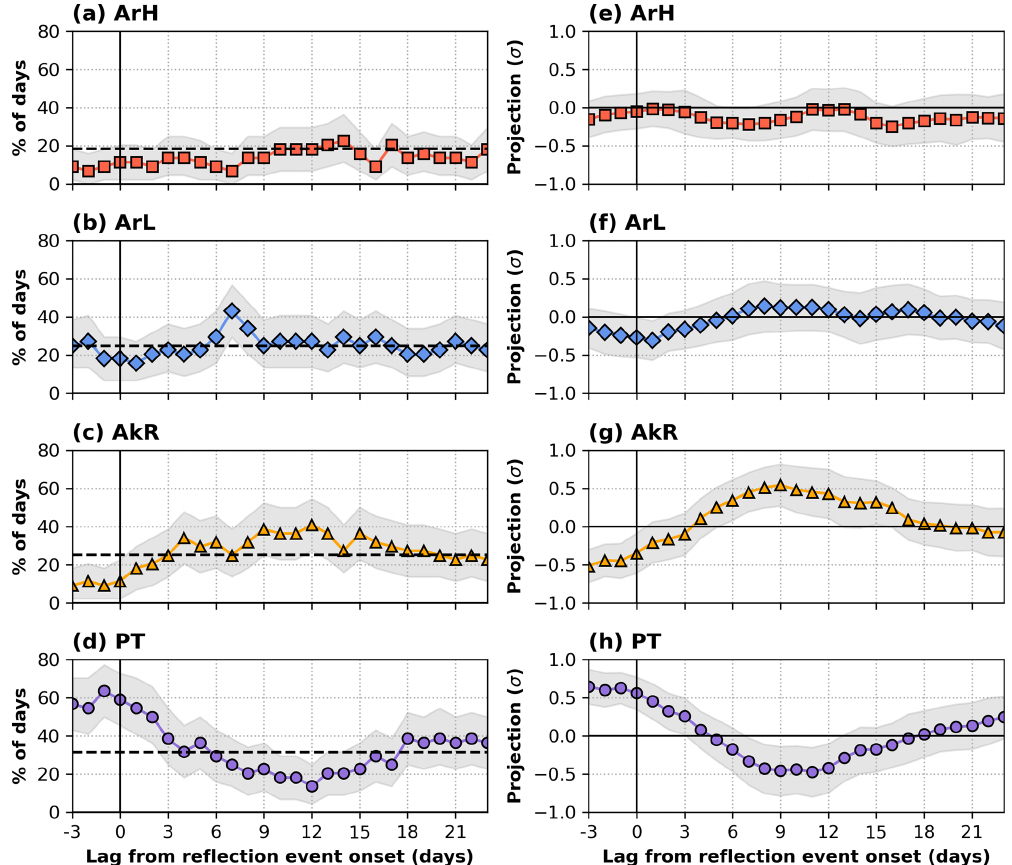
Figure 8. (a–d) Proportion of days in the 44-event sample assigned to each regime. The horizontal dashed lines indicate the climatological DJFM frequency of each regime. (e–h) Mean normalised projection onto each regime for the 44 events. Grey shading indicates 95% confi- dence intervals assessed as described in Sect.